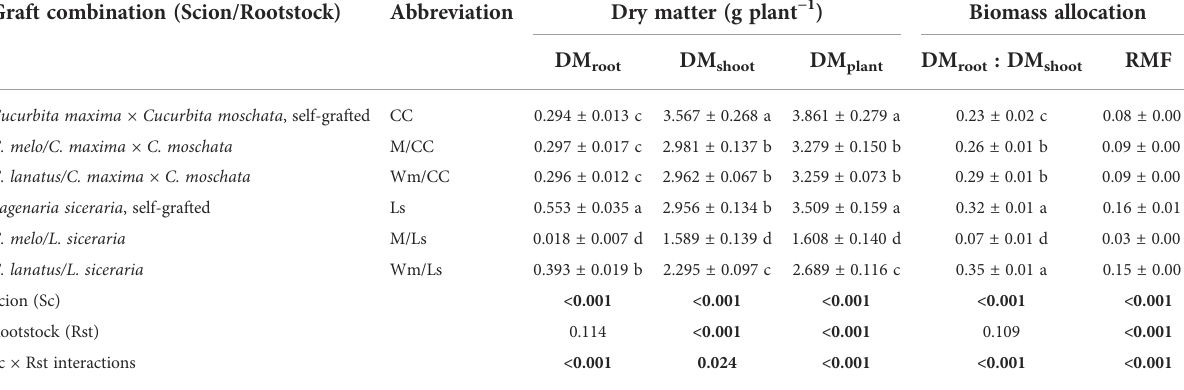
TABLE 1 Dry matter of roots (DM root ), shoots (DM shoot ), and the entire plant (DM plant ) of graft combinations of the rootstocks Cucurbita maxima × Cucurbita moschata (CC) and Lagenaria siceraria (Ls), with melon ( Cucumis melo ; M), watermelon ( Citrullus lanatus ; Wm), or self-grafted at day 60 after grafting (DAG